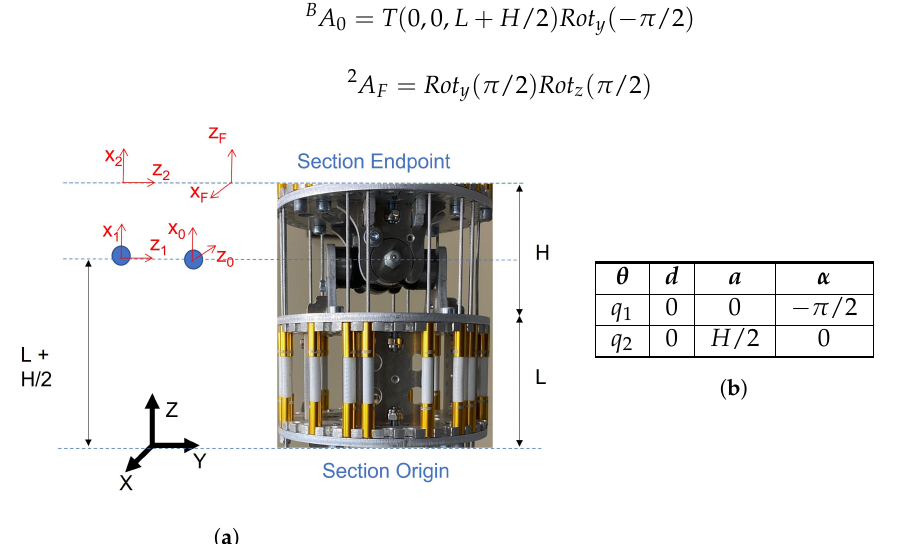
Figure 24. DH method for MACH-I. ( a ) Schematic figure for the application of the Denavit– Hartenberg algorithm to MACH-I. ( b ) Denavit–Hartenberg parameters for such a